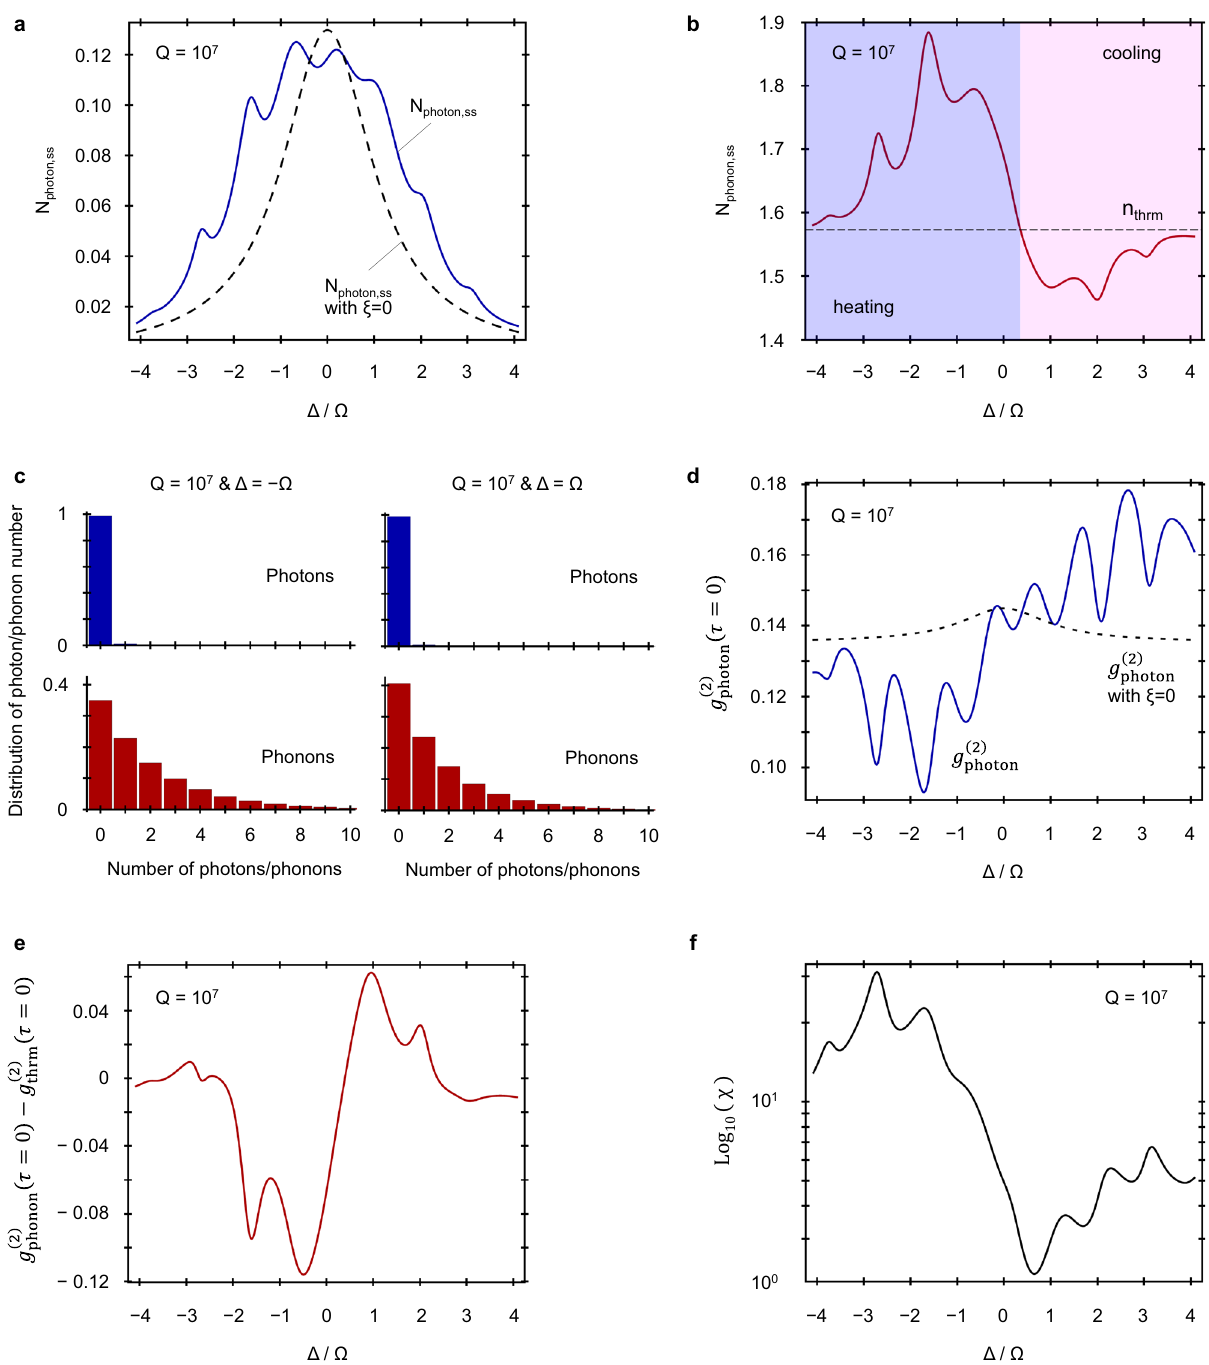
Fig. 5 Steady-state solutions of one-atom optomechanical microlaser. a Steady-state number N photon ; ss of intracavity photons as a function of the atom – cavity detuning Δ . For comparison, N photon ; ss of the corresponding one-atom microlaser in the absence of the optomechanical coupling (i.e. zero optomechanical constant ξ ¼ 0) is also plotted. The mechanical oscillation frequency Ω is chosen as the frequency unit. The corresponding steady-state number N phonon ; ss of phonons is shown in b . The blue shade denotes the heating regime with N phonon ; ss > n thrm while the pink shade corresponds to the cooling regime with N phonon ; ss < n thrm . Here, n thrm denotes the average number of thermal quanta. c Distributions of photon and phonon numbers with Δ ¼ ± Ω . d Dependence of the second-order correlation function g ð 2 Þ ð τ Þ of photons at the zero-time delay τ ¼ 0 on the detuning Δ . The second-order correlation function of the common photon one-atom microlaser with fi xed cavity mirrors ( ξ ¼ 0) is also plotted for comparison. e Second-order correlation function g ð 2 Þ ð τ ¼ 0 Þ of phonons relative to phonon the second-order correlation function g ð 2 Þ ð τ ¼ 0 Þ of the thermal state. f Ratio χ (cid:3) ½ g ð 2 Þ ð 0 Þ(cid:8) 2 = g ð 1 Þ ð 0 Þ g ð 1 Þ ð 0 Þ vs. the atom – cavity detuning Δ . Here, thrm photon (cid:2) phonon photon phonon g ð 2 Þ ð 0 Þ denotes the cross-correlation function between photons and phonons. For all curves, the cavity Q factor is 10 7 and the pump rate is set at photon (cid:2) phonon R (cid:4) 2 π ´ 0 : 35